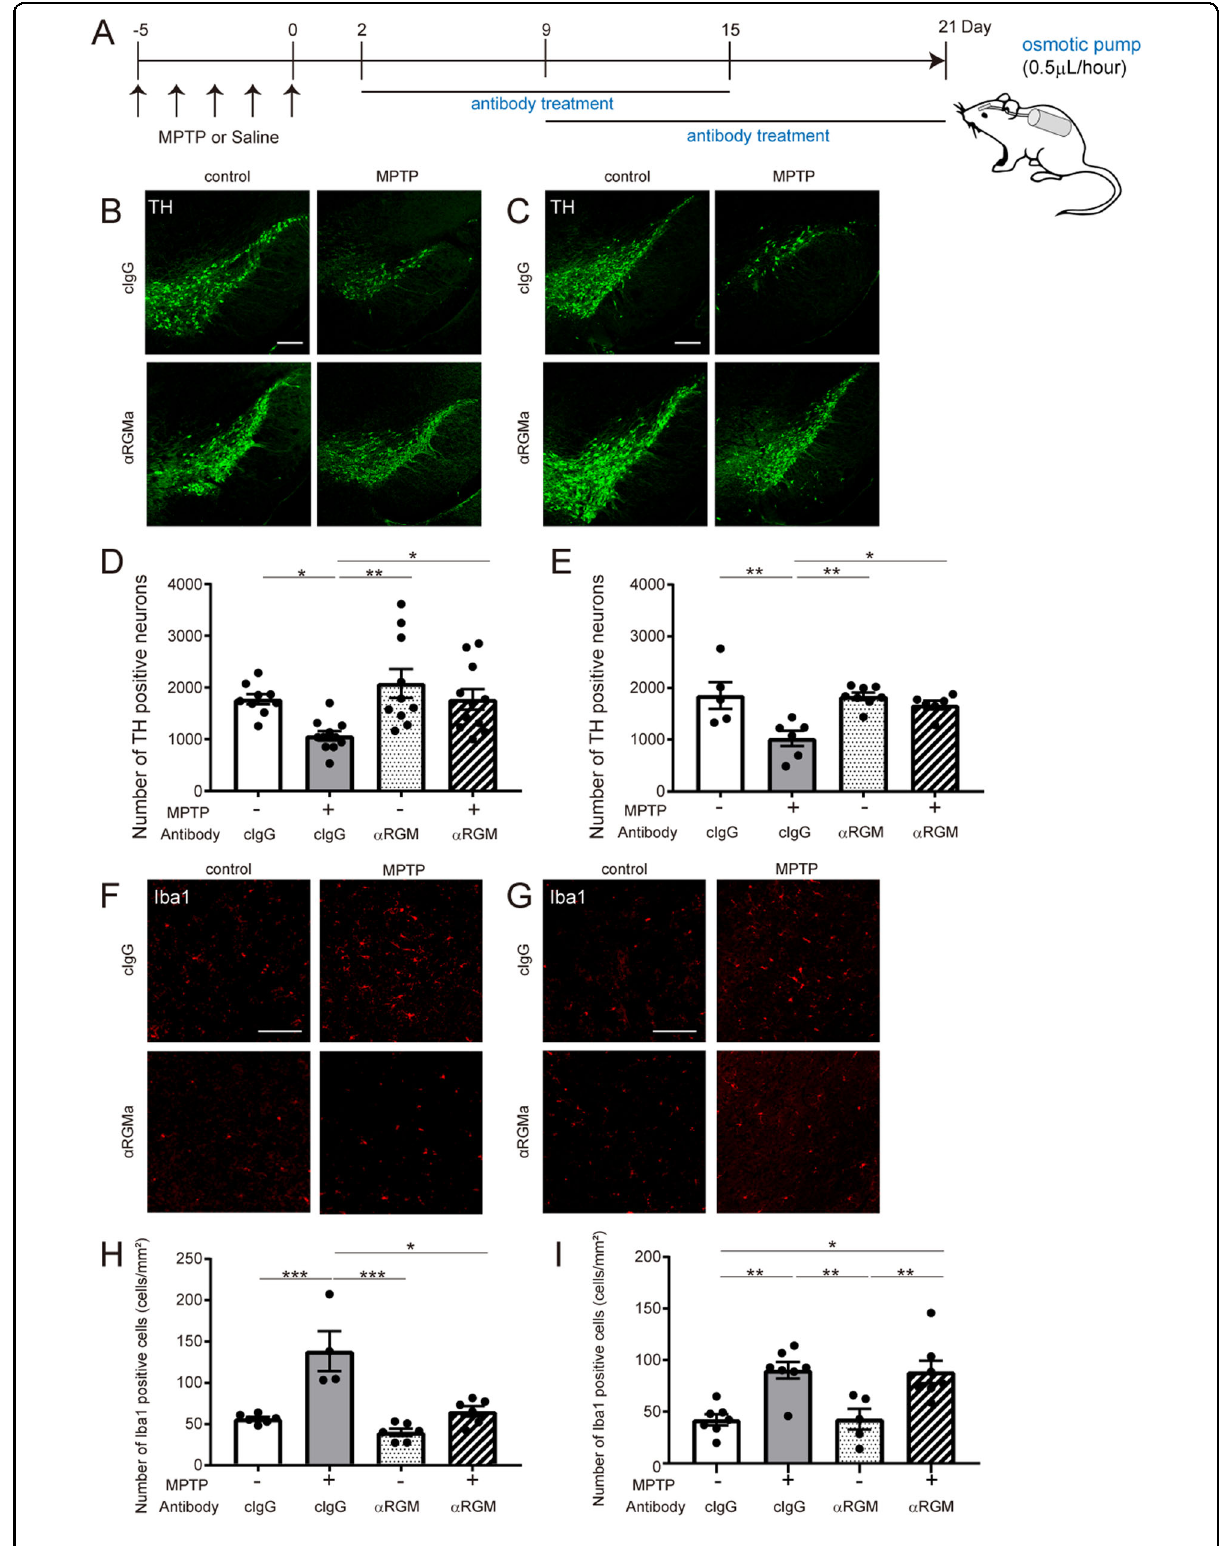
Fig. 2 (See legend on next